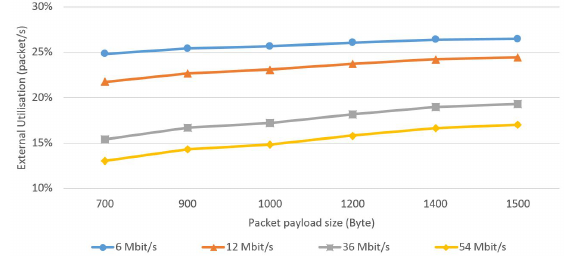
Figure 11: Channel utilisation for externals in Scenario 3.